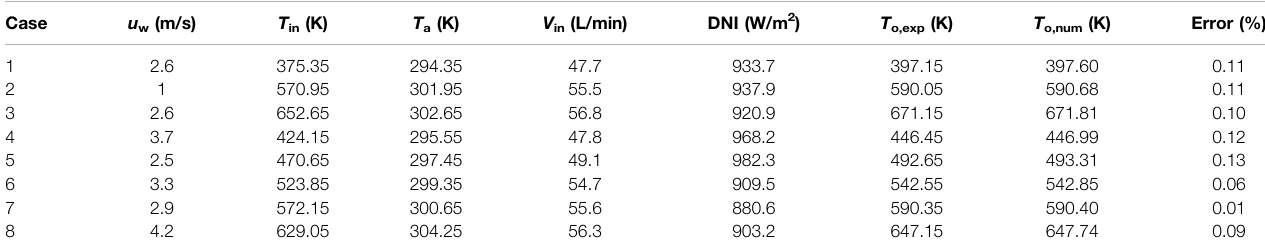
TABLE 3 | Comparative veri fi cation of the fl ow-heat exchange-radiation component with experimental results (Dudley et al., 1994).